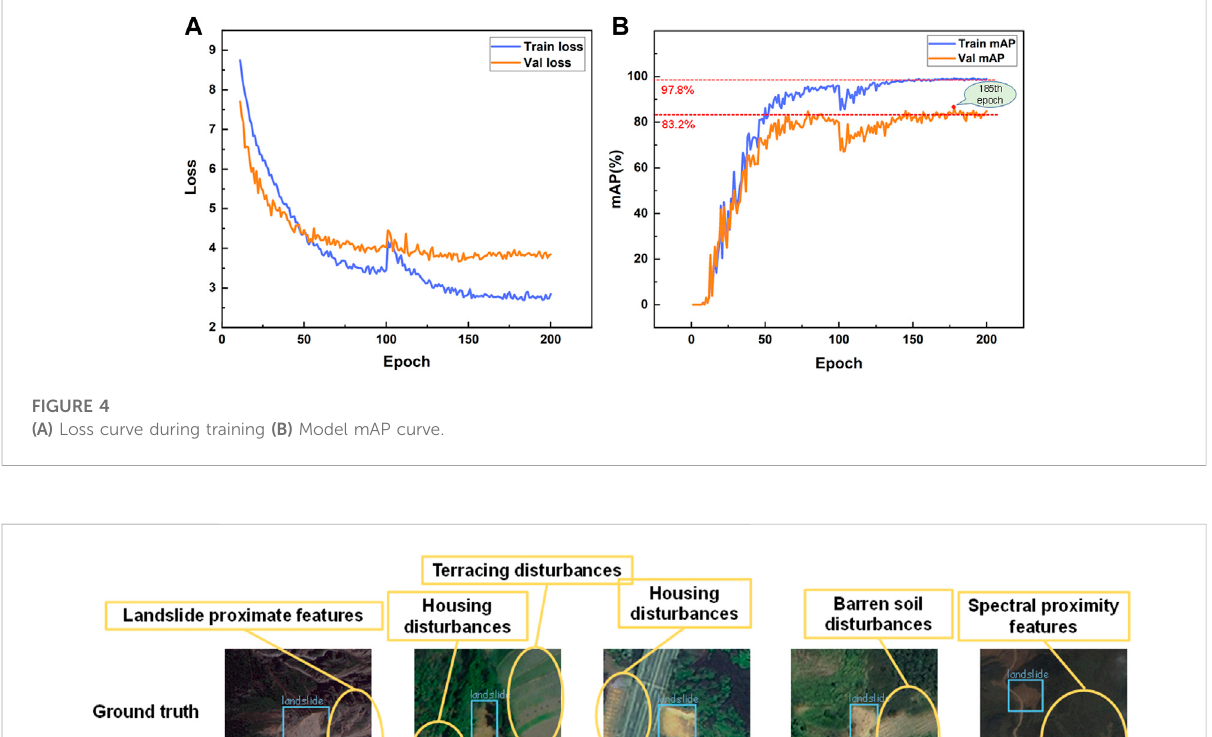
above criteria, we counted the number of landslide images with complex backgrounds in the test set, for a total of 80 images. We employed the developed Dynahead-Yolo to detect complex background landslides images, and compared them with the prediction results of YOLOv3. Figure 5 shows the ground truth, detected results of Dynahead-Yolo and YOLOv3. The blue bounding box is manually annotated label. The green bounding box is the correctly predicted detection box, which